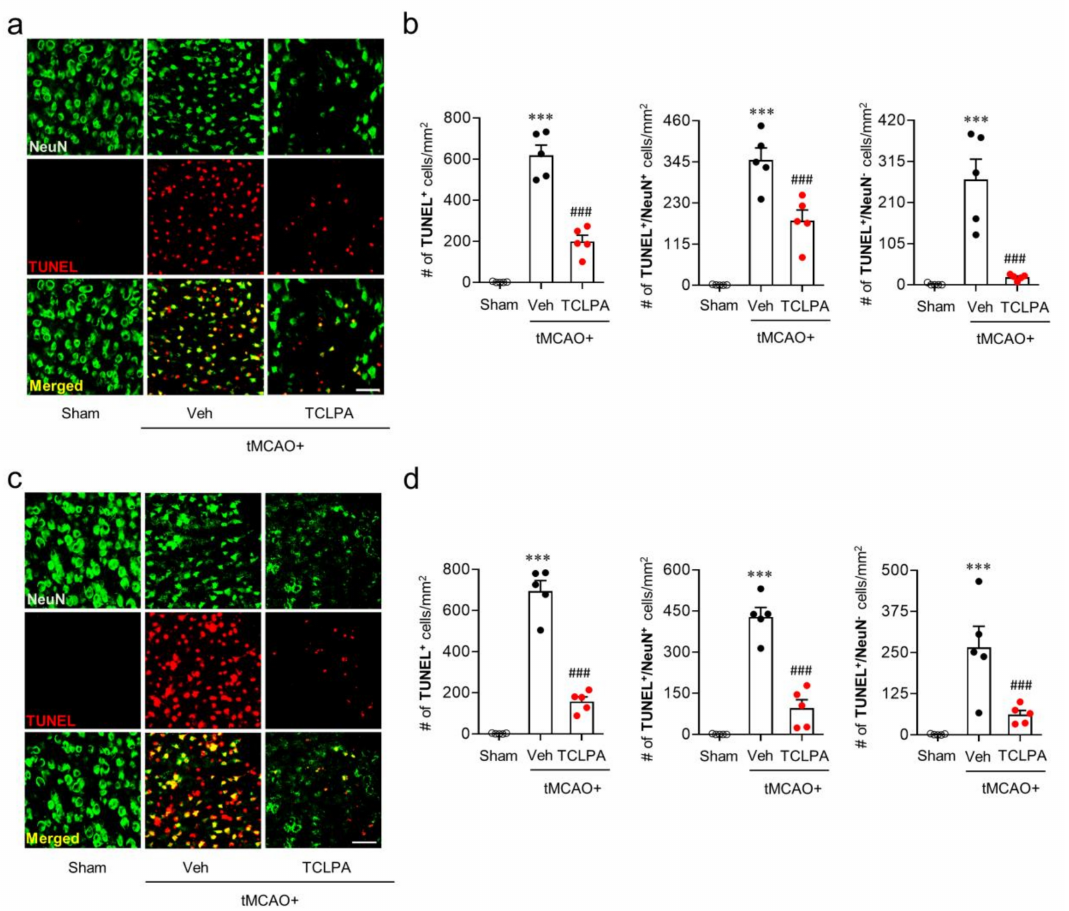
Figure 3. LPA 5 antagonism attenuates neuronal and non-neuronal apoptosis in the injured brain after tMCAO challenge. Mice were challenged with tMCAO, and TCLPA5 (TCLPA: 10 mg / kg, i.p.) was administered immediately after reperfusion. Neuronal and non-neuronal apoptosis was determined by TUNEL assay at one and three days after tMCAO challenge. ( a , b ) E ff ects of TCLPA5 on neuronal and non-neuronal apoptosis were assessed at one day after tMCAO challenge. Representative images of TUNEL-positive and TUNEL / NeuN-double positive cells in the ischemic core region ( a ) and quantification ( b ). ( c , d ) E ff ects of TCLPA5 on neuronal and non-neuronal apoptosis were assessed at three days after tMCAO challenge. Representative images of TUNEL-positive and TUNEL / NeuN-double positive cells in the ischemic core region ( c ) and quantification ( d ). Scale bars, 50 µ m. n = 5 mice per group. *** p < 0.001 versus sham; ### p < 0.001 vs. vehicle-administered tMCAO